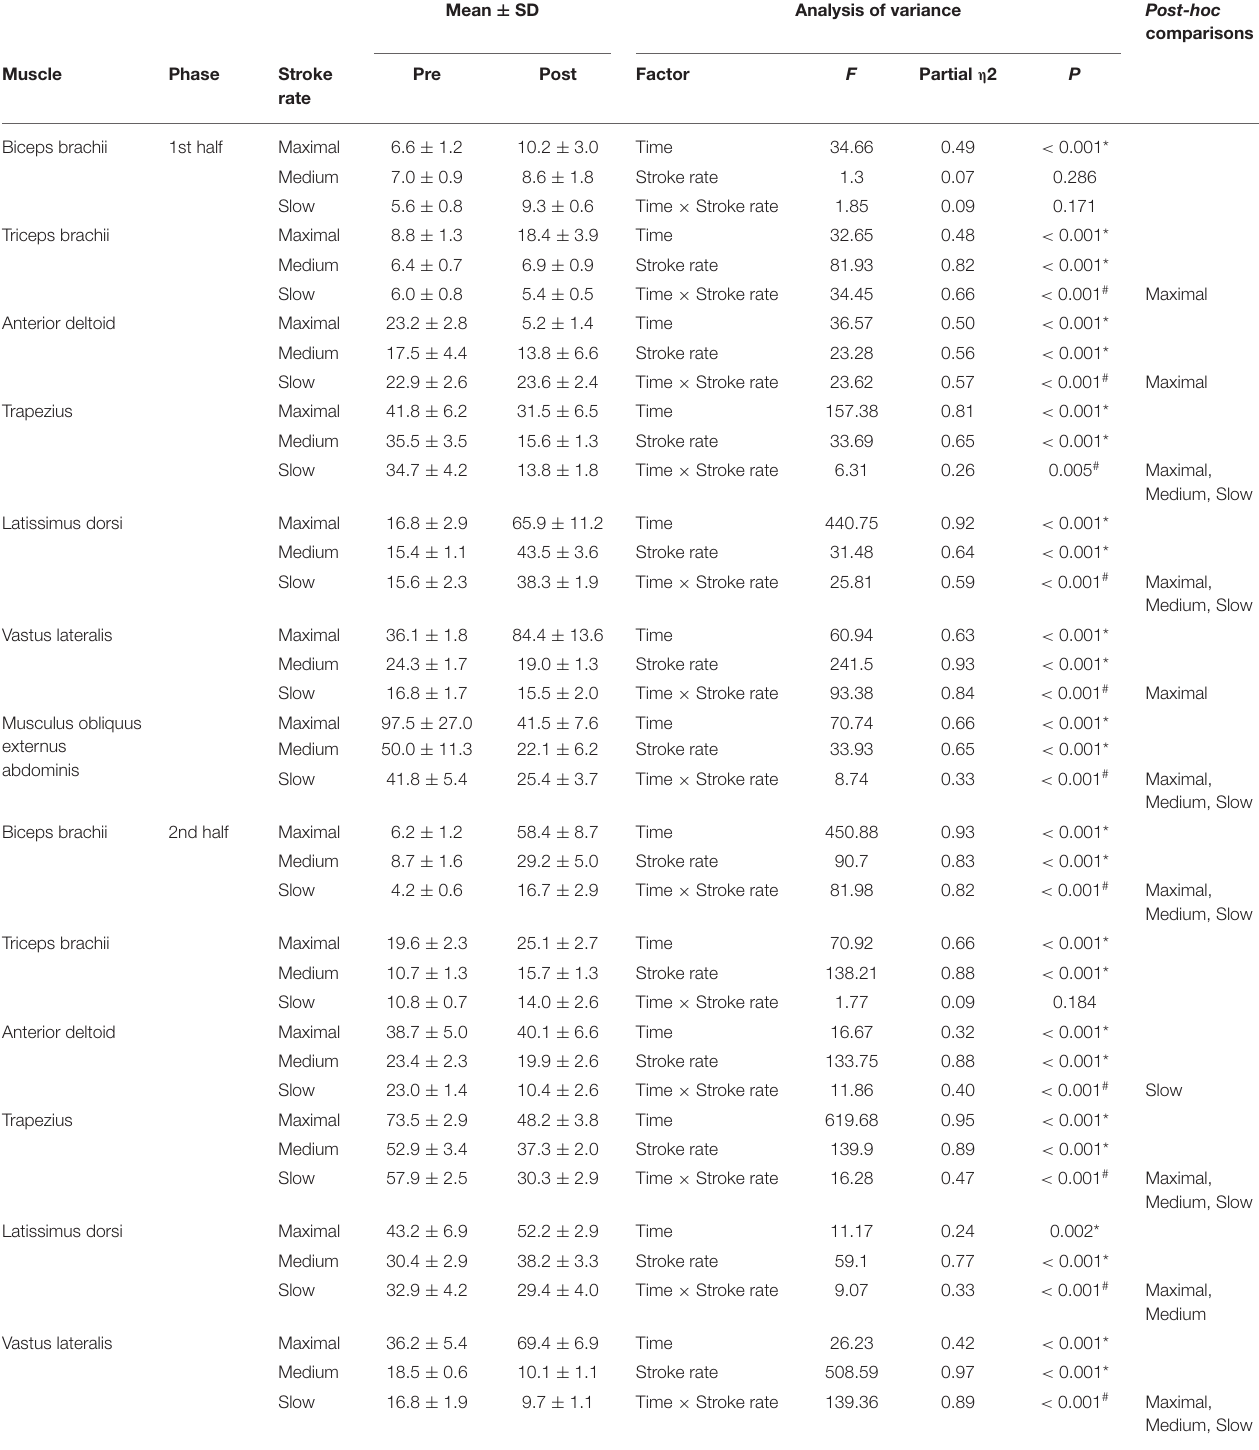
TABLE 3 | Effect of 4-week kayaking training on the EMG activities for each muscle at 1st and 2nd halves of pull phase. Mean ± SD Analysis of